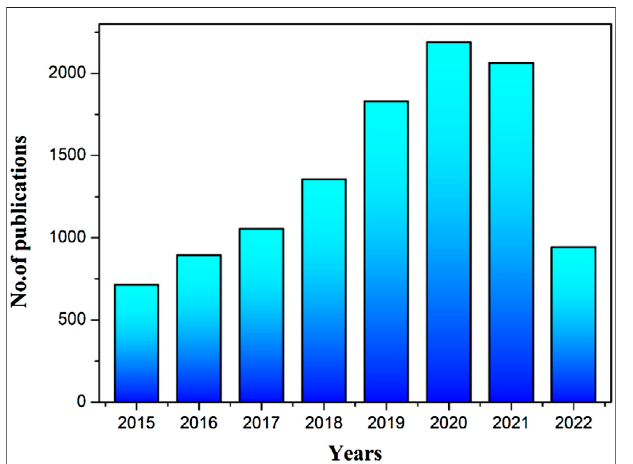
FIGURE 1 | The bar graph representing the increasing trend in the number of publications on “ CQDs ” in the period of 2015 to May 2022. These results were obtained from the Scopus database by using the keyword “ carbon quantum dots ” in the article title and abstract.